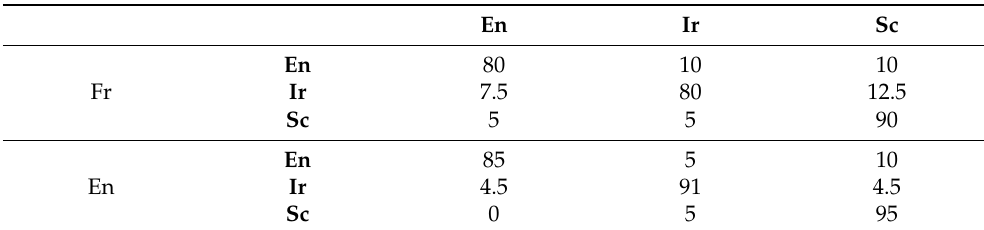
Table 4. Comparison of average confusion matrices for original English and French classification experiments using PoS n-grams feautures. En Ir Fr